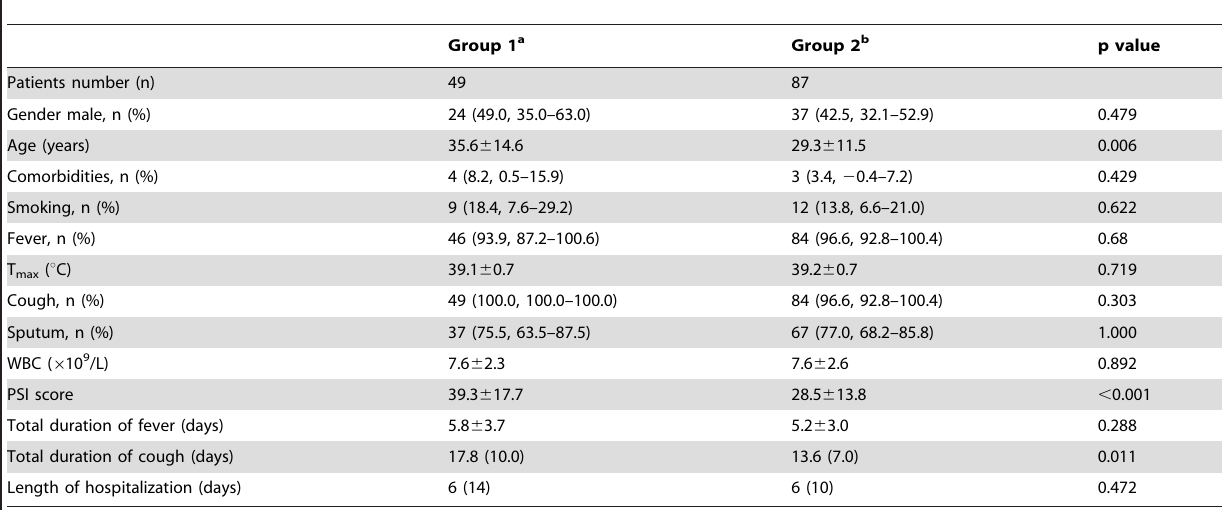
Table 4. Comparison of Clinical features in CAP patients between two MLVA